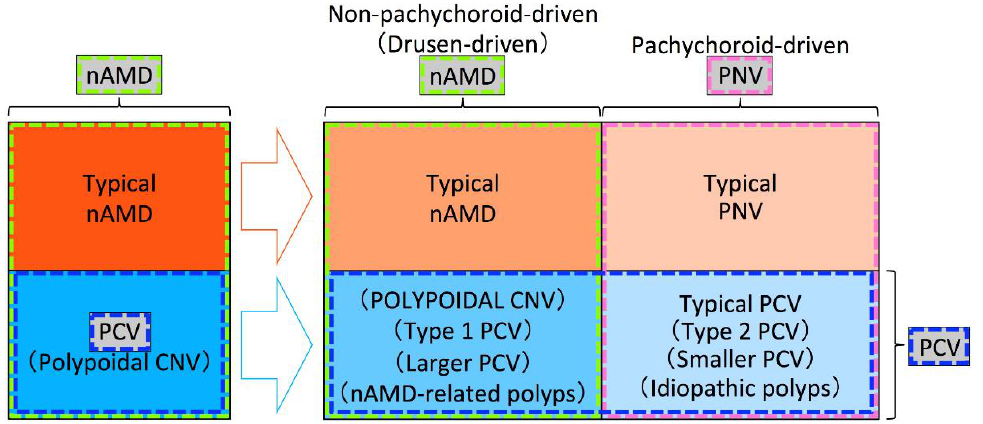
Figure 4. An example of a framework used in previous studies. Among exudative maculopathy previously diagnosed as nAMD, typical nAMD is divided into typical nAMD that is non-pachychoroid-driven (drusen-driven) and typical pachychoroid neovasculopathy (PNV) that is pachychoroid-driven, and polypoidal choroidal vasculopathy (PCV) is divided into non-pachychoroid-driven (drusen-driven) macular neovascularization (MNV) with polypoidal lesions and pachychoroid-driven MNV with polypoidal lesions, in the era of the pachychoroid concept. nAMD includes both non-pachychoroid-driven MNV without and with polypoidal lesions. PNV includes both pachychoroid-driven MNV without and with polypoidal lesions. PCV includes both non-pachychoroid-driven MNV with polypoidal lesions and pachychoroid-driven MNV with polypoidal lesions. Pachychoroid-driven MNV with polypoidal lesions should be called typical PCV and an appropriate term for non-pachychoroid-driven MNV with polypoidal lesions has not yet been proposed. Since the “polypoidal CNV” had been proposed for CNV in PCV or PCV itself and the usage of “POLYPOIDAL CNV” by Yuzawa et al. differs from the originally used term “polypoidal CNV”, “POLYPOIDAL CNV” by Yuzawa et al. is written in uppercase for differentiation.